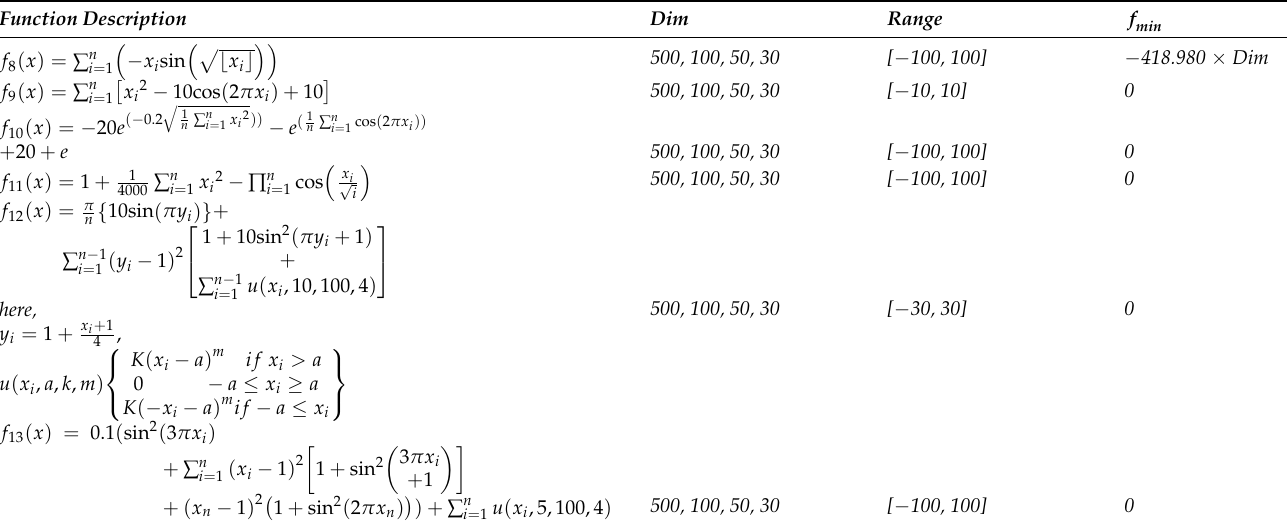
Table A2. Utilized Multimodal Test Functions.